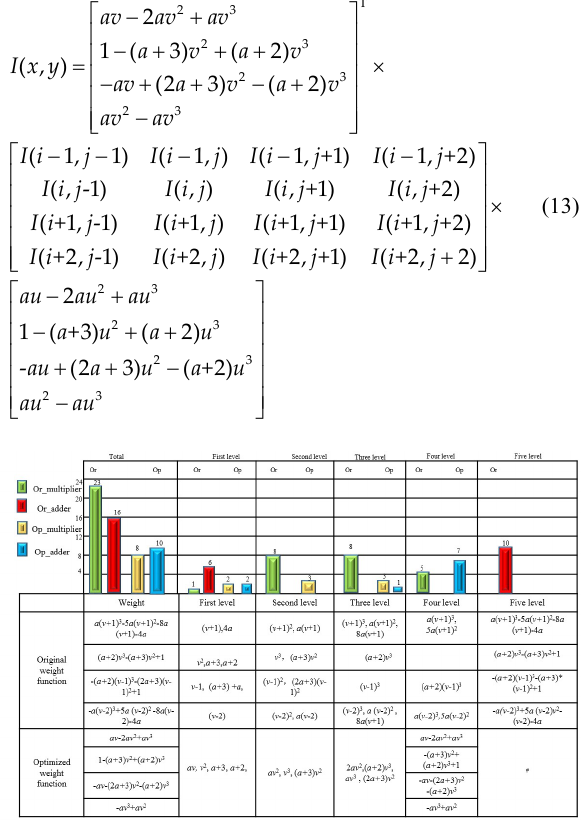
 Figure 4. Optimization weight of v and u. Or: Original; Op: Optimized